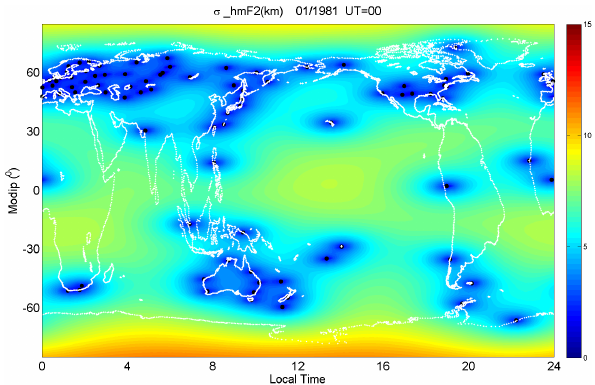
Fig. 2. A sample map of the standard deviation obtained when doing the kriging